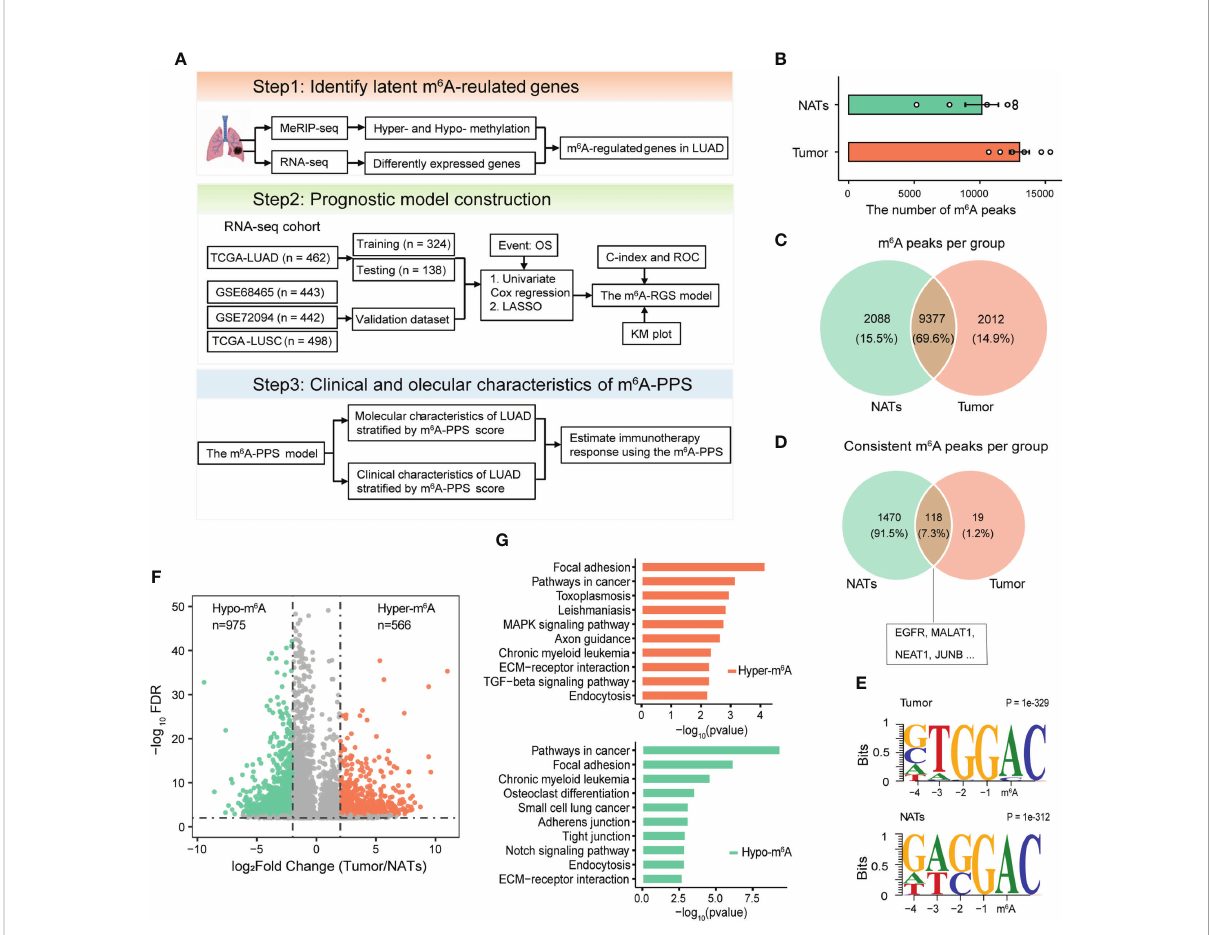
FIGURE 1 Design overview and analyses of the m 6 A methylomes of LUAD. (A) Schematic fl ow chart to identify a prognostic signature based on m 6 A- regulated genes. (B) The number of m 6 A peaks detected per sample in tumors and paired NATs. (C, D) Venn diagrams showing the overlapping m 6 A methylated transcripts (C) and consistent m 6 A methylated transcripts (D) in tumors and paired NATs. (E) Motif analysis for detected m 6 A peaks revealing similar consensus in tumors and paired NATs. (F) Volcano plot showing the differentially methylated peaks (log2FC > 1 and P-adjusted< 0.05). (G) KEGG pathway enrichment analysis of hyper- and hypo-methylated